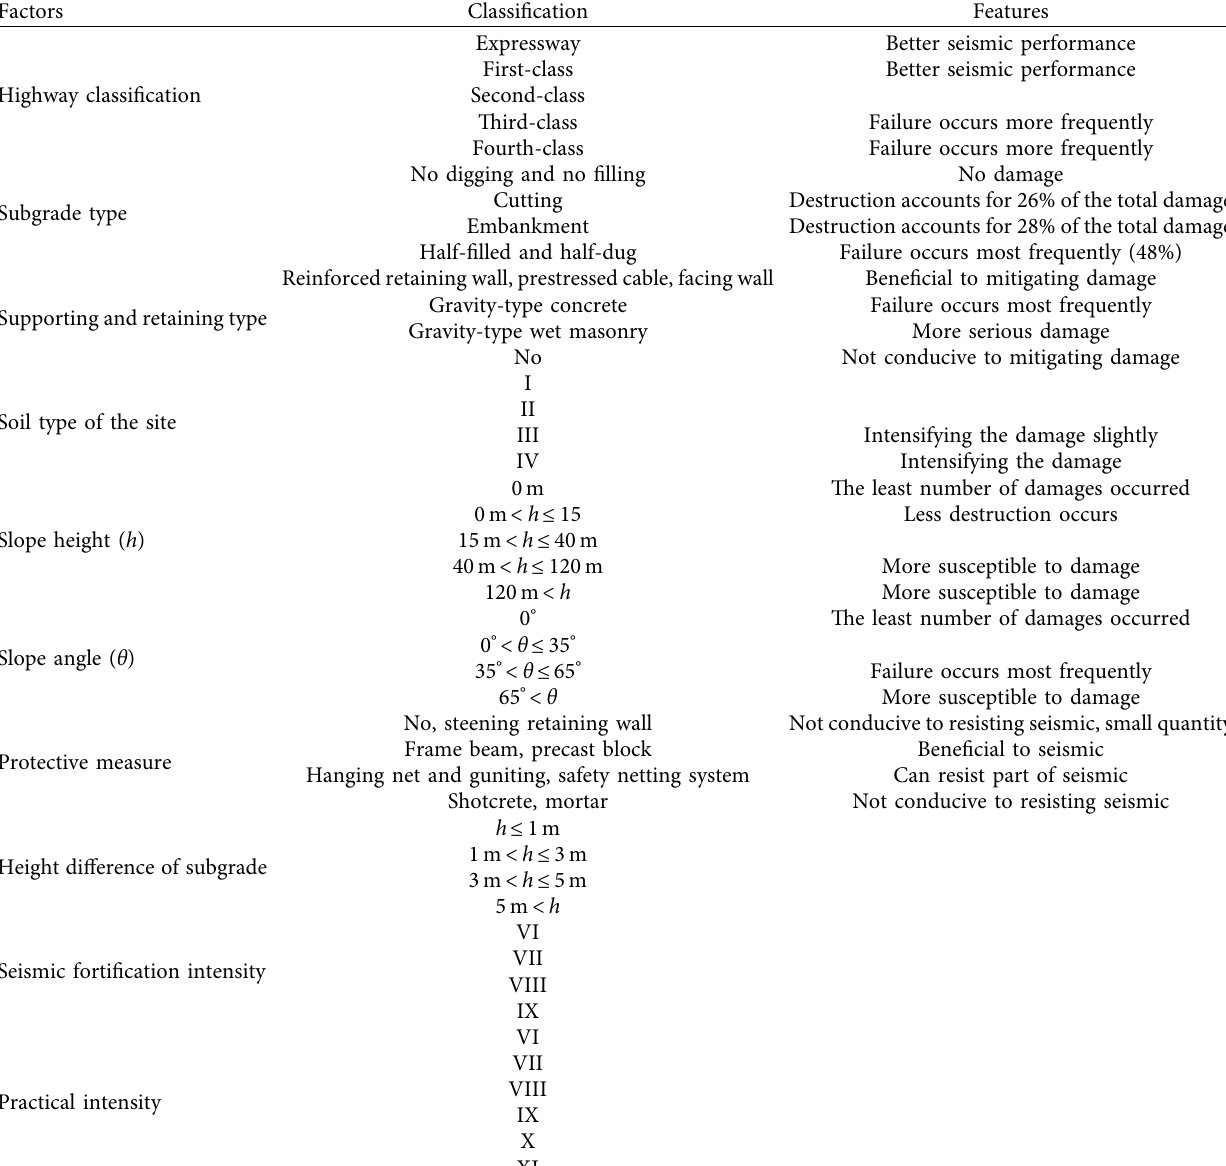
Table 4: Factors of seismic road